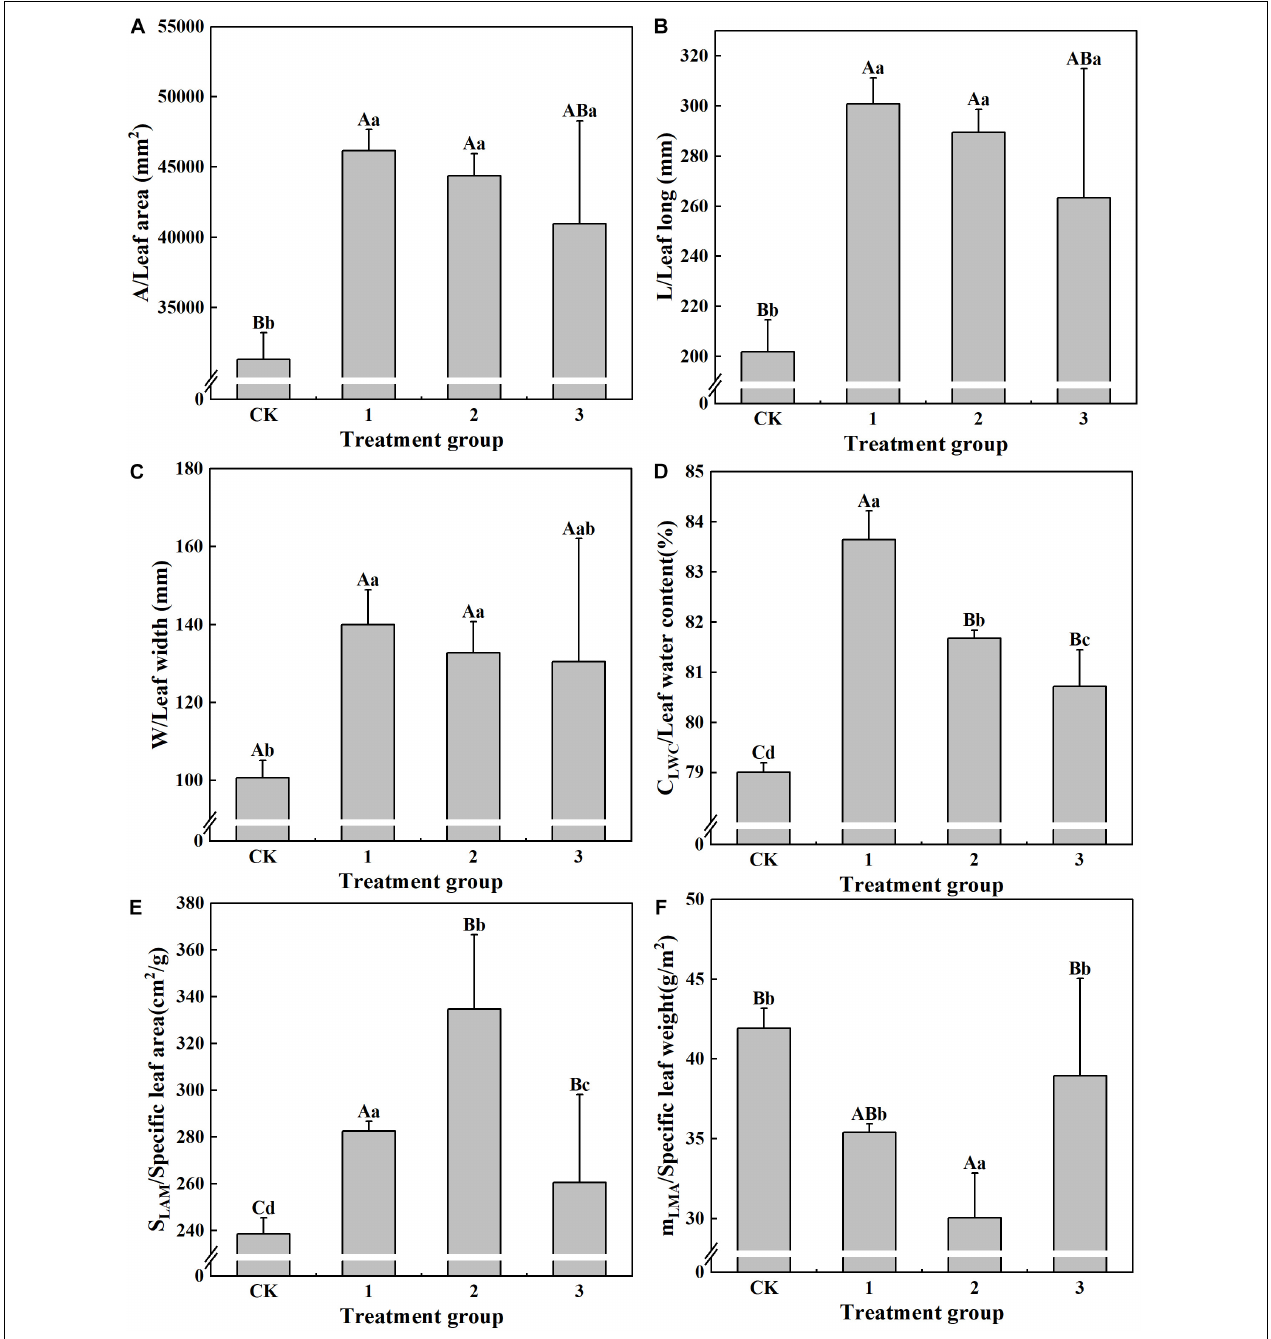
FIGURE 2 | The effect of different treatments on the leaf properties of Horsfieldia hainanmensis The uppercase letters in the figure indicate P < 0.01, and the lowercase letters indicate P < 0.05, which, respectively, indicate extremely significant and significant differences (A–F) , respectively, represent the different light transmittance to Horsfieldia hainanmensis the leaves A (Leaf area). L (Leaf long) W (Leaf width) C LWC (Leaf water content) S LAM (Specific leaf) and m LAM (Specific leaf height).